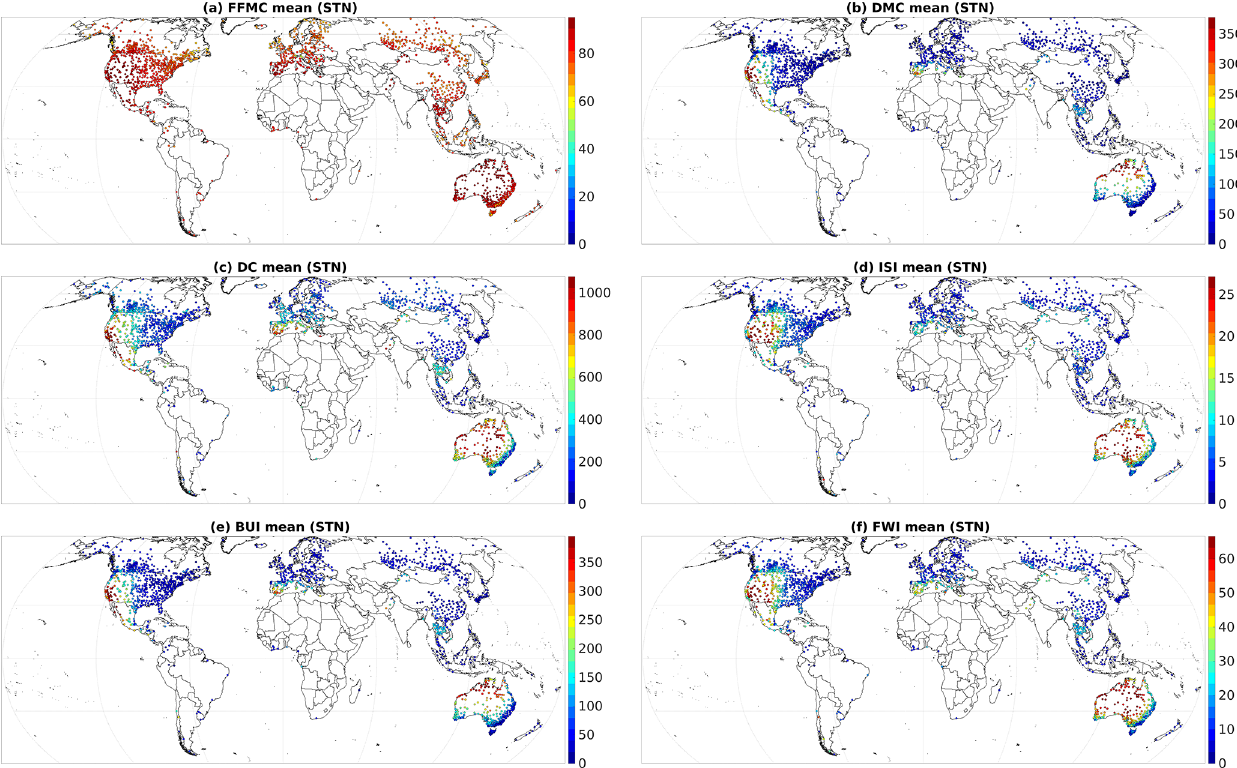
Figure 4. 2004–2018 mean of Fire Weather Index (FWI) components calculated from weather station data, only over the local 4-month fire